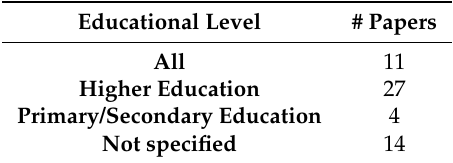
Table 5. Number of papers per educational level.